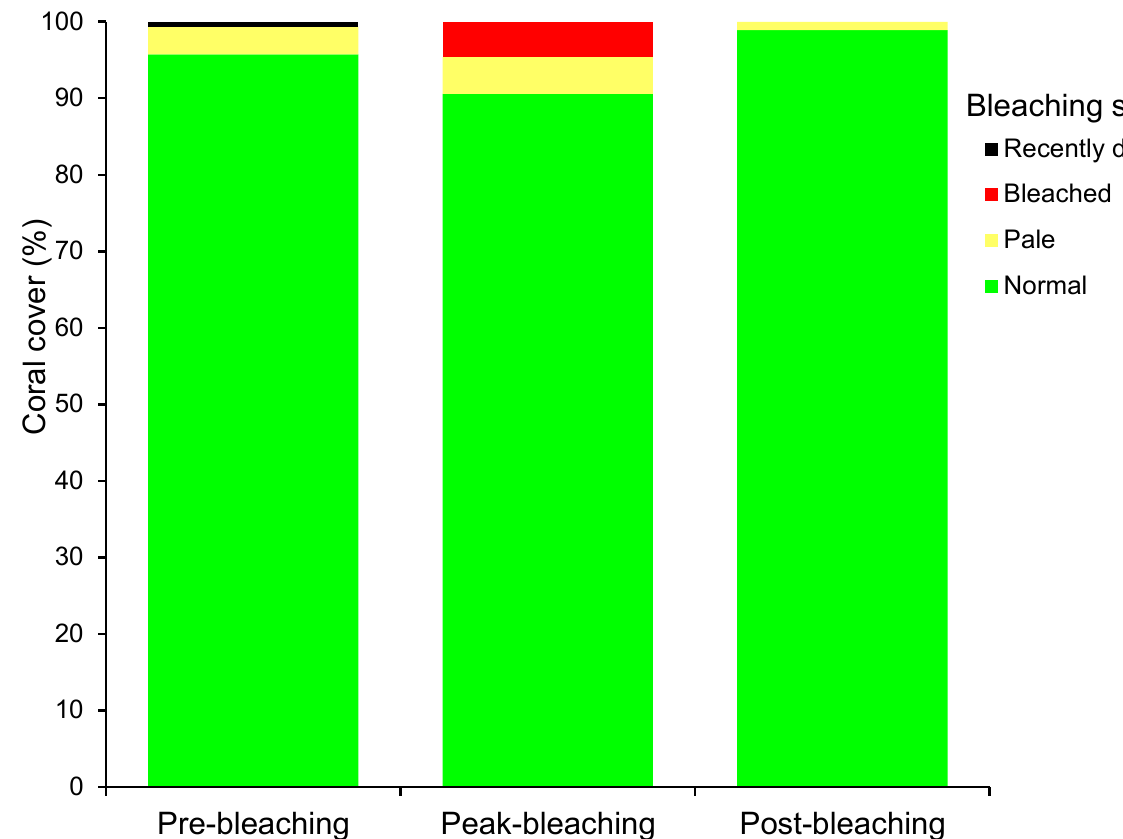
Figure 6. Average bleaching severity as a proportion of total coral cover, assessed at five sites on Two-mile Reef, Central Reef Complex, using point-intercept transects during pre-, peak- and post-bleaching periods (2015–2016).